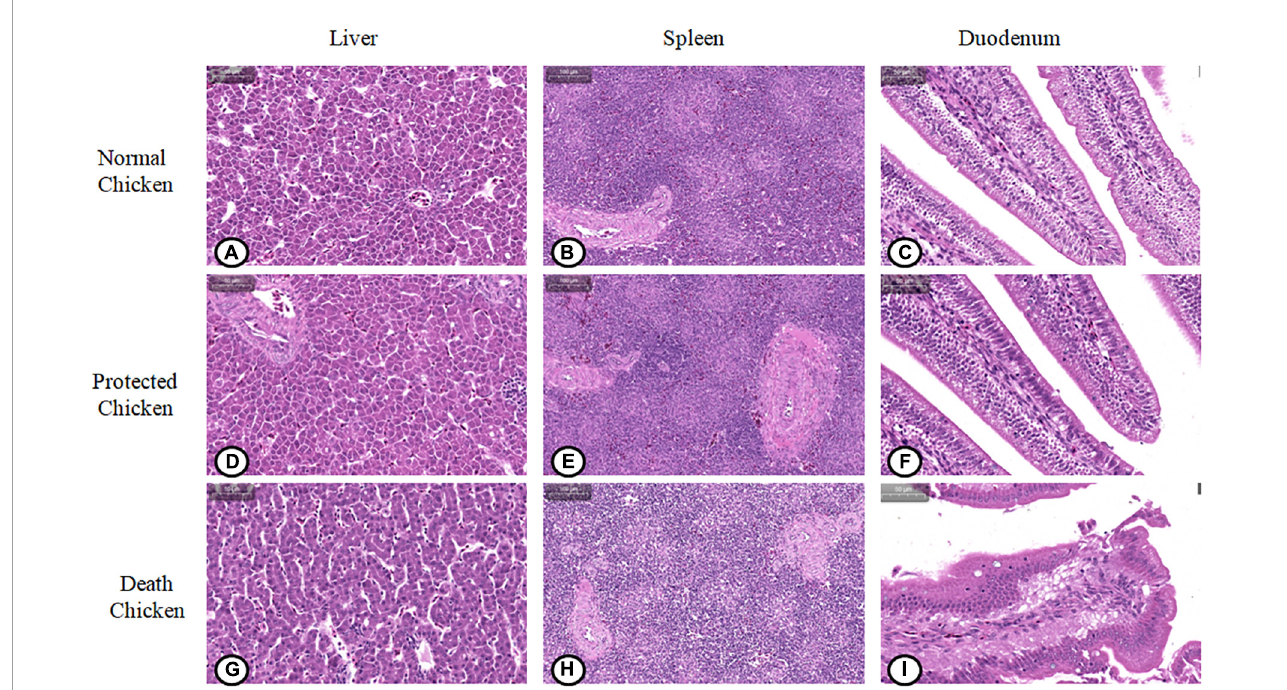
FIGURE7 Pathological changes of viscera and organs in chickens infected with Salmonella pullorum. (A) Liver of normal chickens; (B) spleen of normal chickens; (C) duodenum of normal chickens; (D) liver of protected chickens; (E) spleen of protected chickens; (F) duodenum of protected chickens; (G) liver of chickens with pathological changes; (H) spleen of chickens with pathological changes; (I) duodenum of chickens with pathological